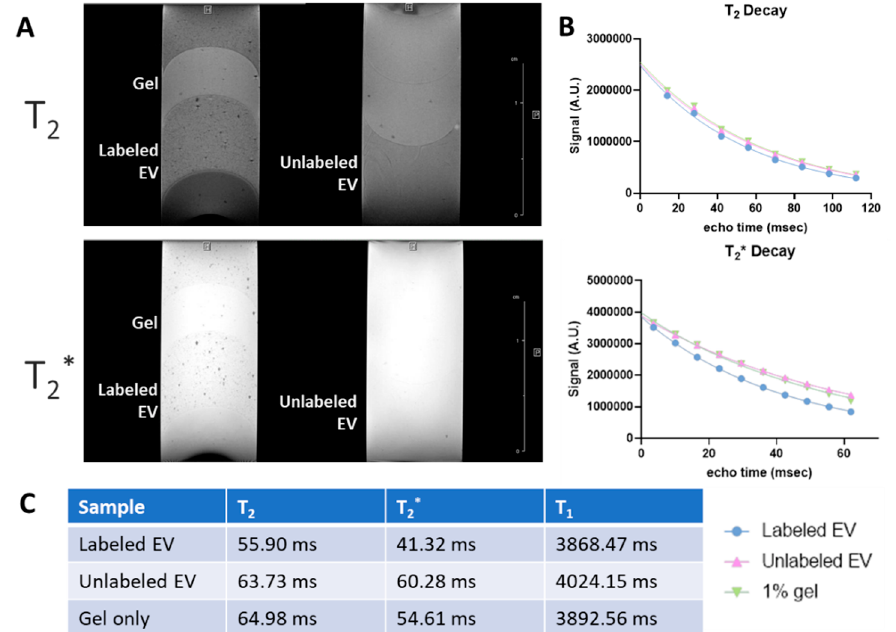
Figure 4. In vitro MRI for labeled brain organoid − EVs (15–20 nm). EVs sonicated with nanoscale iron oxides, 6 cycles: 30 s on/30 s off. Layered in agarose gel; ( A ) Preliminary results show the contrast of EVs containing iron oxides in MR images. ( B ) T 2 and T 2* decay rates are demonstrated for labeled and unlabeled EV compared to gel only. ( C ) T 2 , T 2* , and T 1 values were extracted from their respective plots.